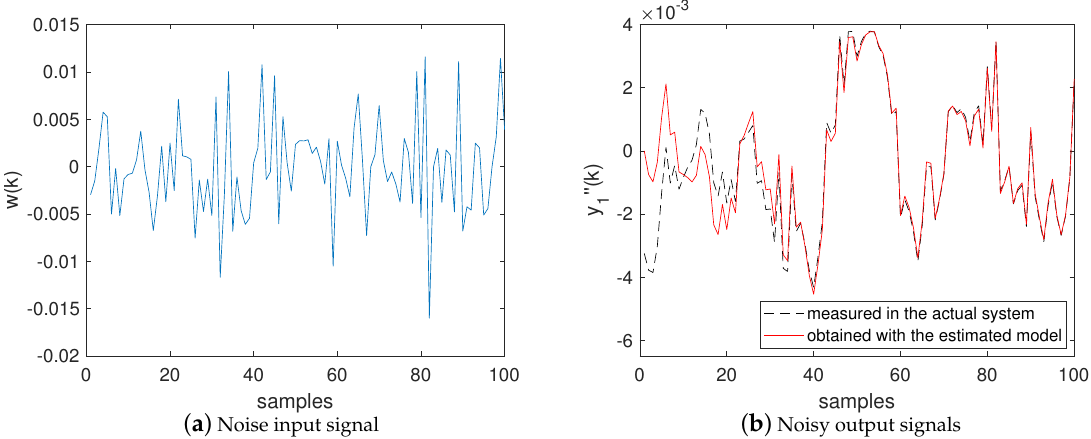
Figure 12. Input and output signals used by the BSA in Algorithm 1 to estimate M ( z ) considering the model defined in (8).